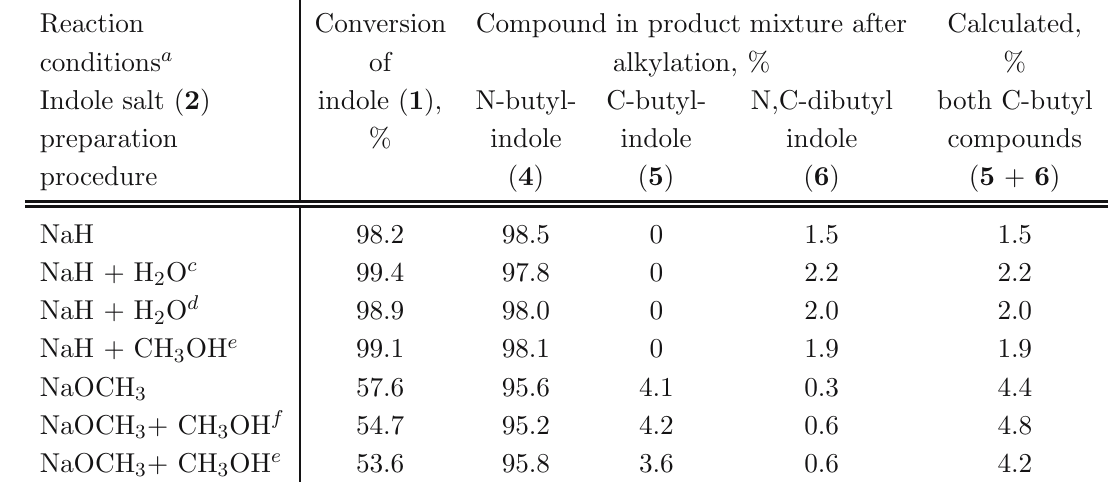
Table 5 Influence of protic solvents on alkylation reaction products of indole sodium salt a,b . Reaction Conversion Compound in product mixture after Calculated, conditions a of alkylation,